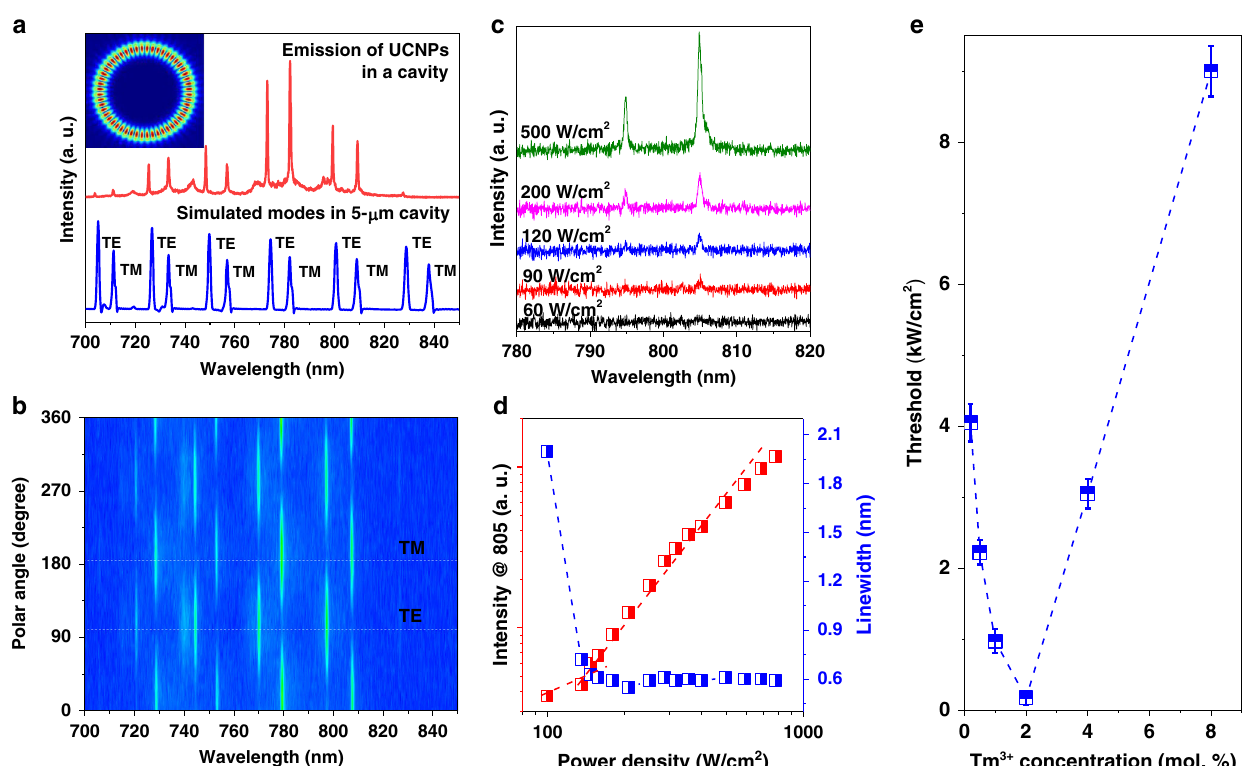
Fig. 3 Characteristics of low threshold upconversion lasing emissions from a single layer of self-assembled UCNPs in a polystyrene microsphere. a Numerical simulations of resonance spectrum and experimental emission spectrum. The inset shows a numerical simulation of the electrical- fi eld distributions at 800 nm within a major plane. b Emission polarization angle-dependent intensities of the lasing peaks. c Power dependent upconversion emission spectra showing the gradual appearance of lasing peaks. d The pumping power-dependent plots of emission intensities and spectral linewidth narrowing, showing the onset of upconversion lasing emissions. e Tm 3 + concentration-dependent thresholds for the onsets of upconversion lasing